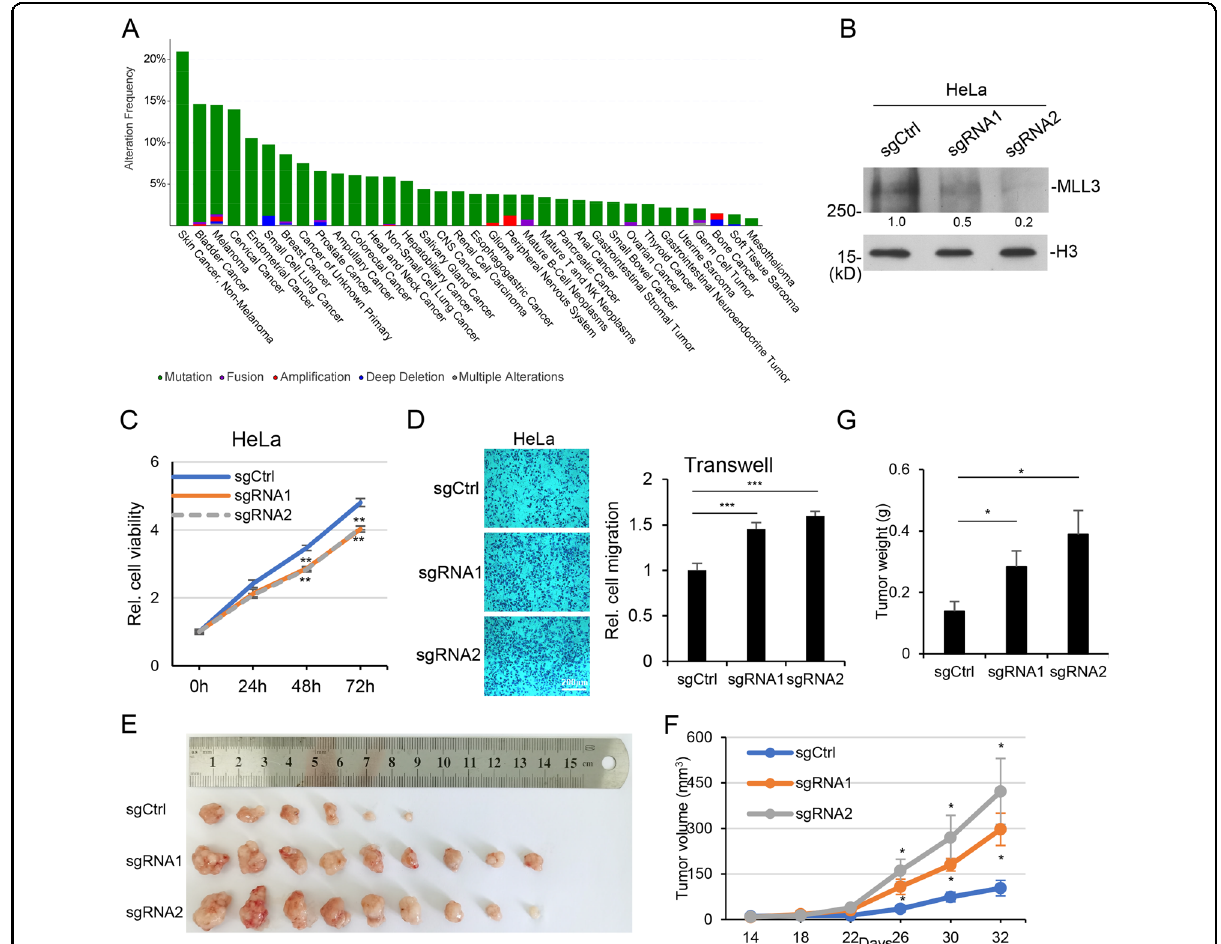
Fig. 1 MLL3 regulates cancer cell migration. A Histogram showing the mutation rates of MLL3 in different types of cancer. Data are from MSK- IMPACT Clinical Sequencing Cohort (MSKCC, Nat Med 2017). B Two independent MLL3 knockdown HeLa cell lines were generated with CRISPR/ Cas9 system. MLL3 protein levels were examined by western blotting. C Cells were prepared as ( B ). Cell viability assay was performed to examine the cell proliferation rates after MLL3 depletion. D Cells were prepared as ( B ) and transwell assay was performed to measure cell migration after MLL3 depletion. E – G Cells were prepared as ( B ) and injected into nude mice. Tumors were pictured ( E ). Tumor growth curves ( F ) and tumor weight ( G ) were shown as mean ± SEM ( n = 6,9,9 respectively). * P < 0.05, ** P < 0.01, *** P <